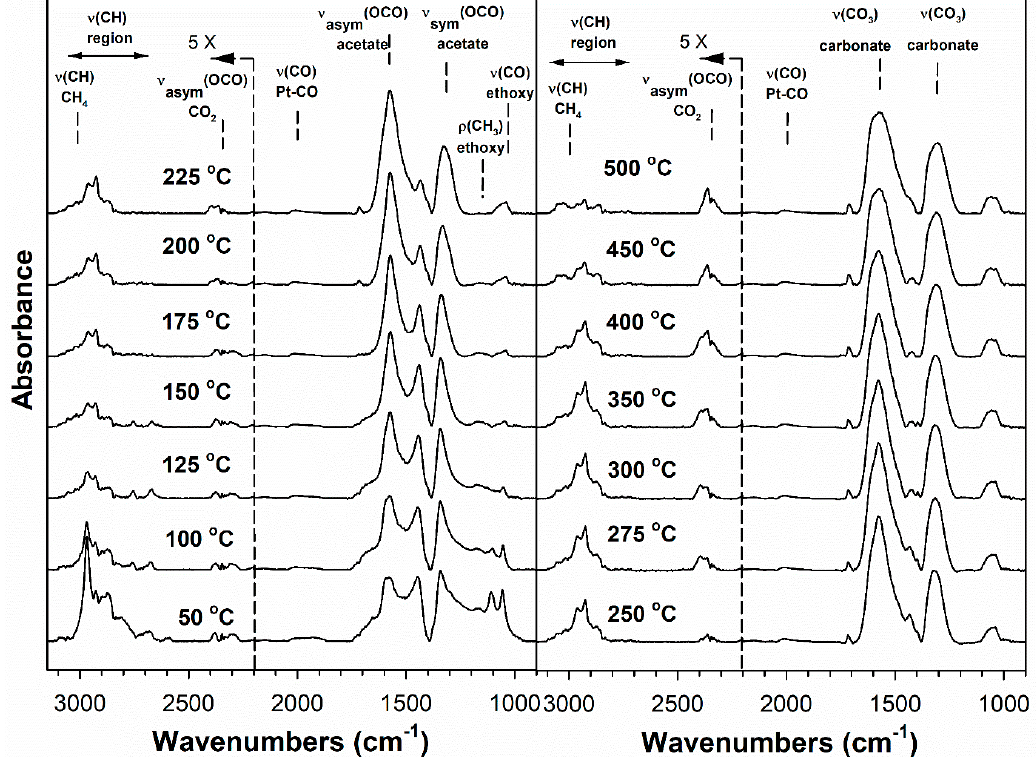
Figure 11. DRIFTS of transient ethanol steam reforming over 14.5% Cs-2% Pt/ZrO 2 .